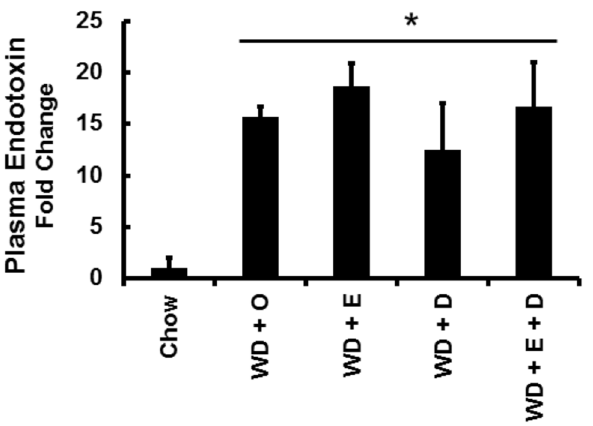
Figure 4. Diet effects on plasma endotoxin. Plasma endotoxin was quantified as described in Materials and Methods. Results are presented as Plasma Endotoxin, Fold Change. Mean ± SD relative to chow fed mice; *, P ≤ 0.05 versus chow.